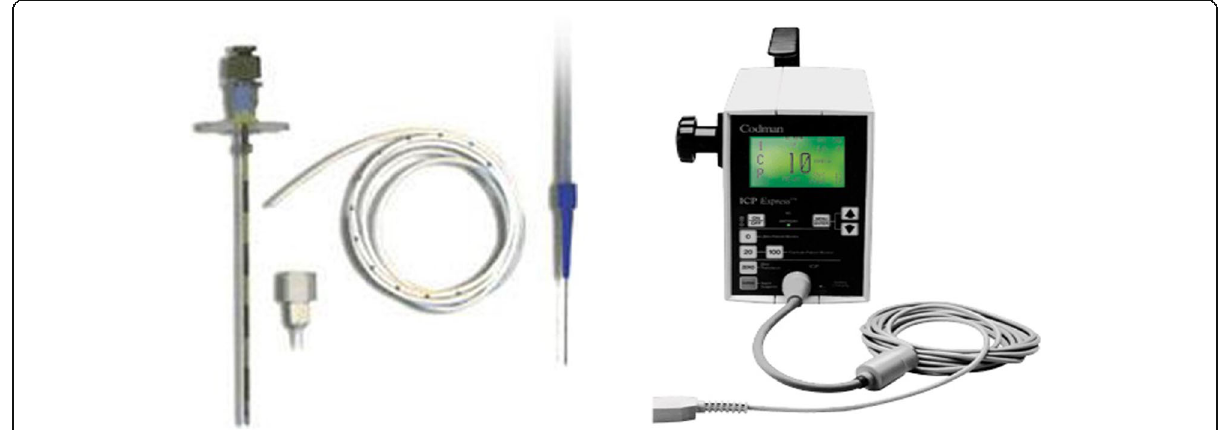
Fig. 1 Codman micro sensor ICP monitor and catheter